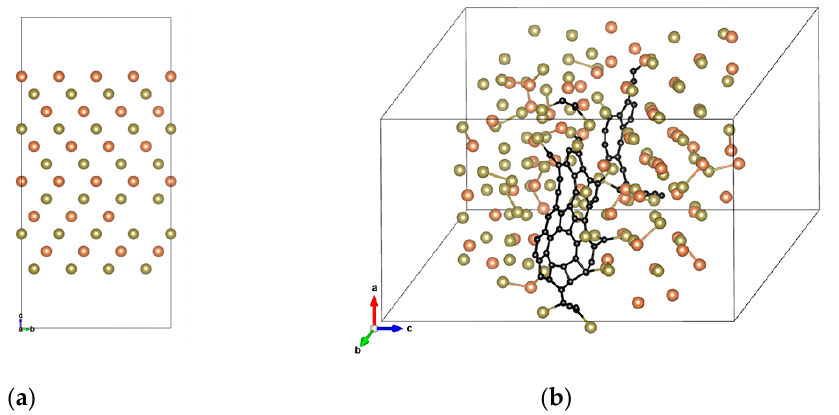
Figure 2. ( a ) The Σ 3 twin grain boundary FCC-Sb 2 Te 3 containing 160 atoms, and ( b ) the C atoms gradually converge at the crystal plane to form C molecular clusters.